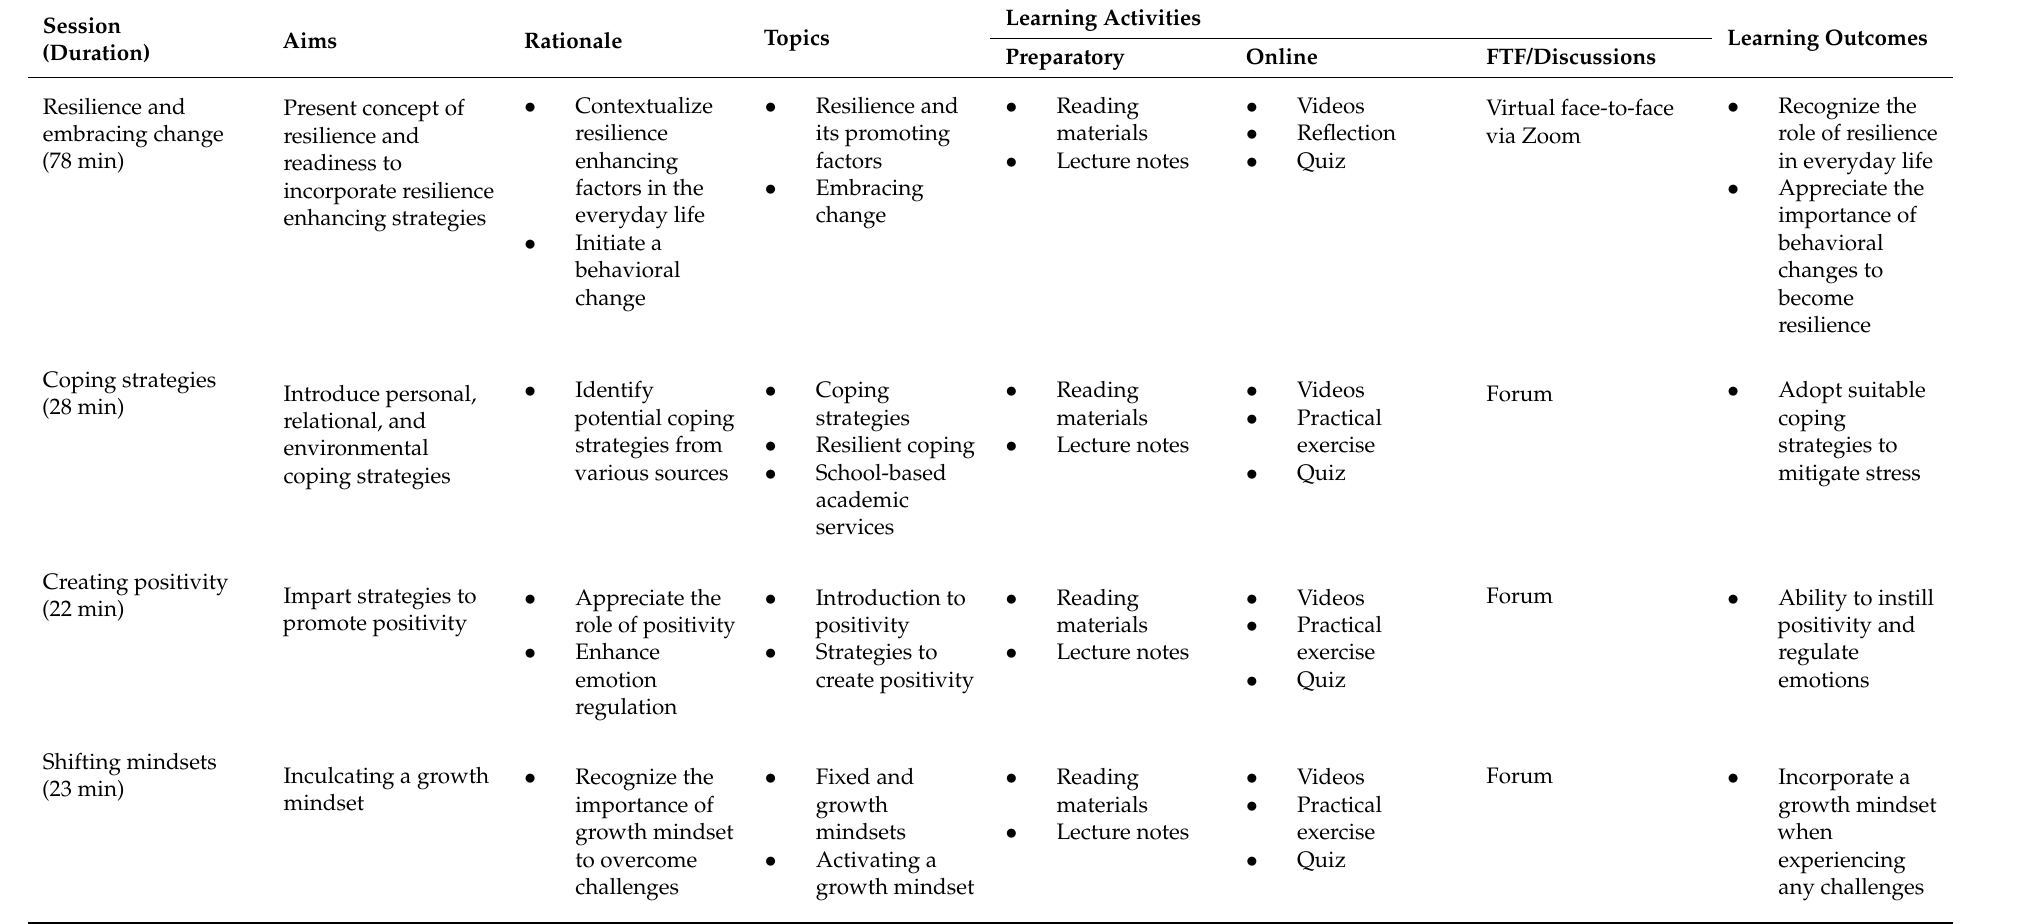
Table 1. Topics, session components, learning activities, and take-home